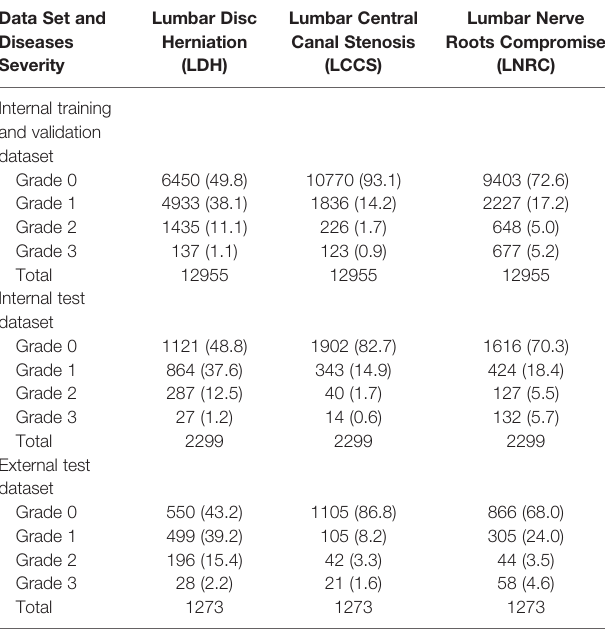
TABLE 2 | Reference standard classi fi cations of the three lumbar diseases at axial T2W MRIs. Data Set and